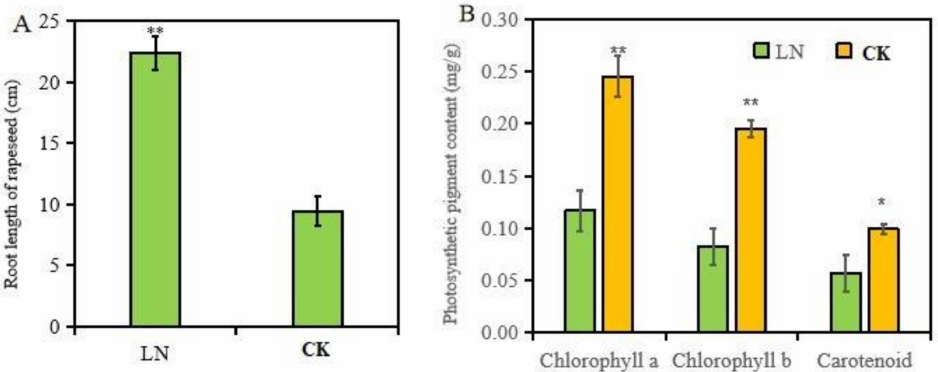
Figure 1. The growth of rapeseed under different N treatment. ( A ) The growth of the whole seedlings; ( B ) leaf size and anthocyanin accumulation in leaves; ( C ) the root morphology reflected by root scanner.